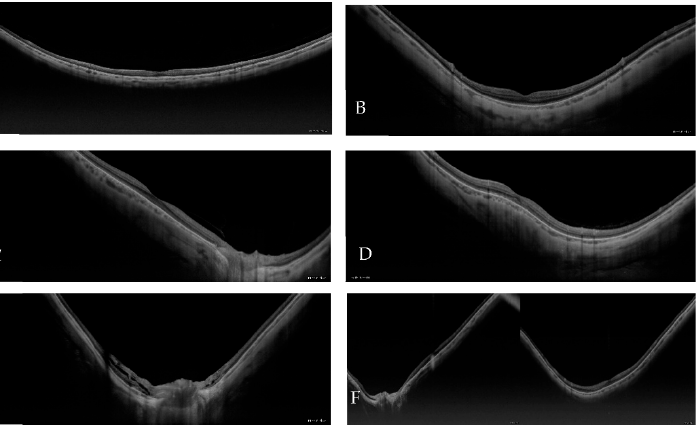
Figure 2. Types of staphylomas: ( A ) wide macular; ( B ) narrow macular; ( C ) nasal; ( D ) inferior; ( E ) peripapillary, and ( F ) other types. All images are horizontal in orientation except D. Atrophic maculopathy grading according to the META-PM classification is pre- sented in Figure 3.